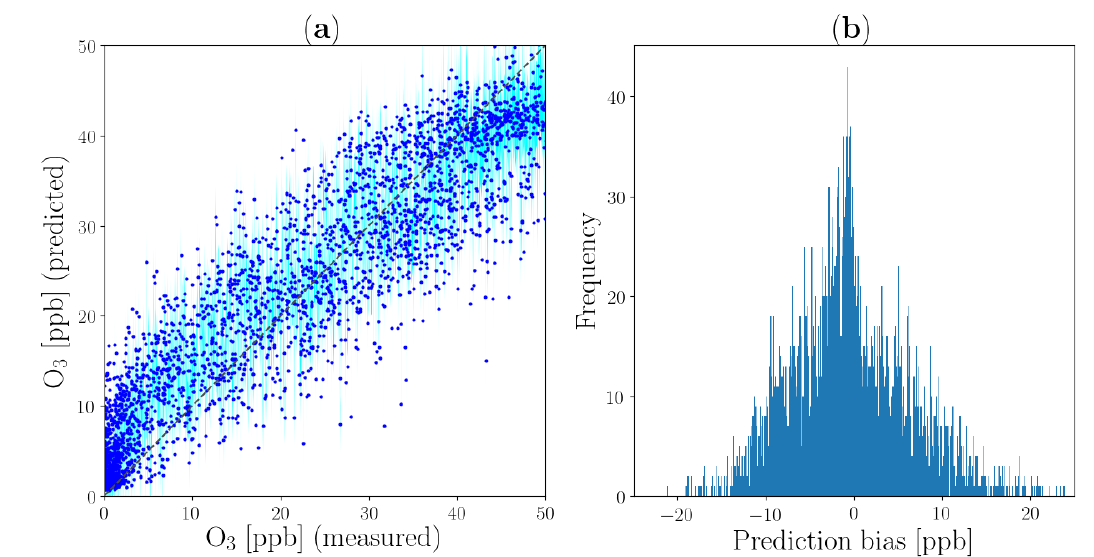
Figure 10. Regression plot ( a ) and the prediction bias ( b ) between the test data of O 3 concentration measurement and the estimated O 3 concentration generated by